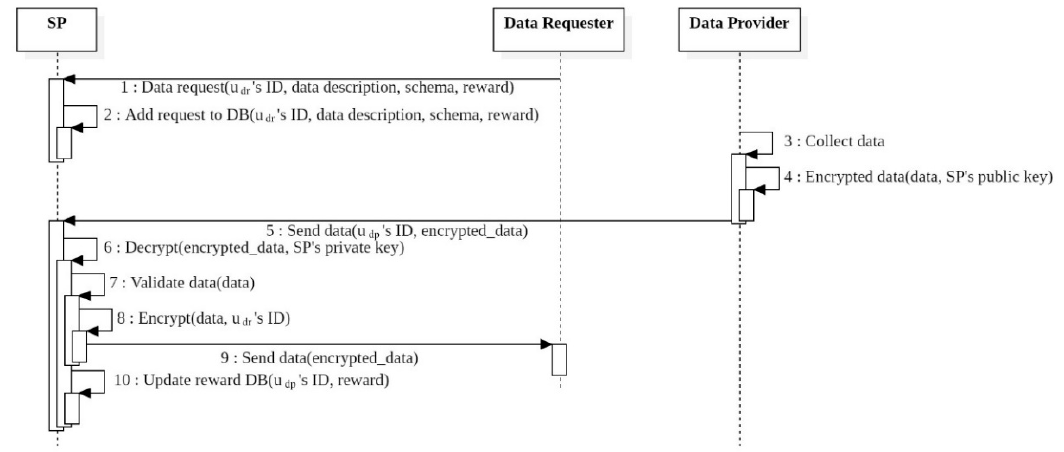
Figure 12. Sequence diagram of traditional method of processing data at the service provider server ( 𝑆𝑃 ).